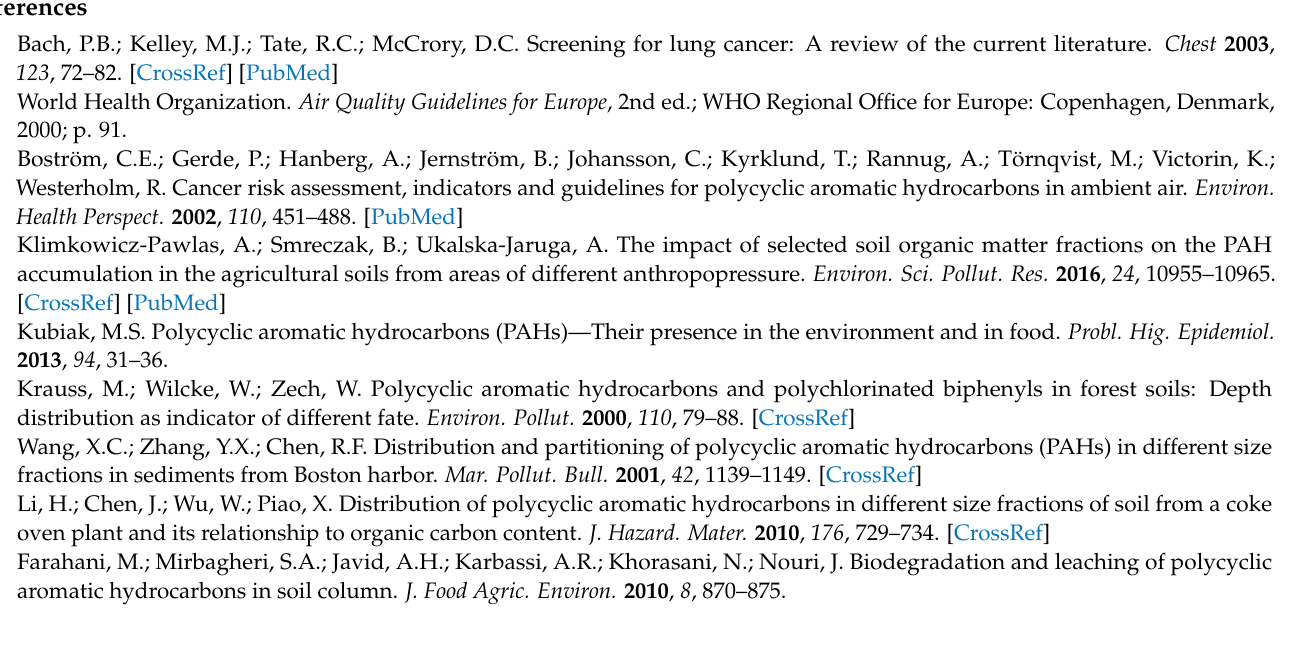
Table S2. Mineral fertilization regime; Table S3. Mean and standard deviationof the content of 16 PAHs in µ g kg − 1 depending on the soil horizon at 0–30 cm and 30–60 cm in the long-term fertilizer